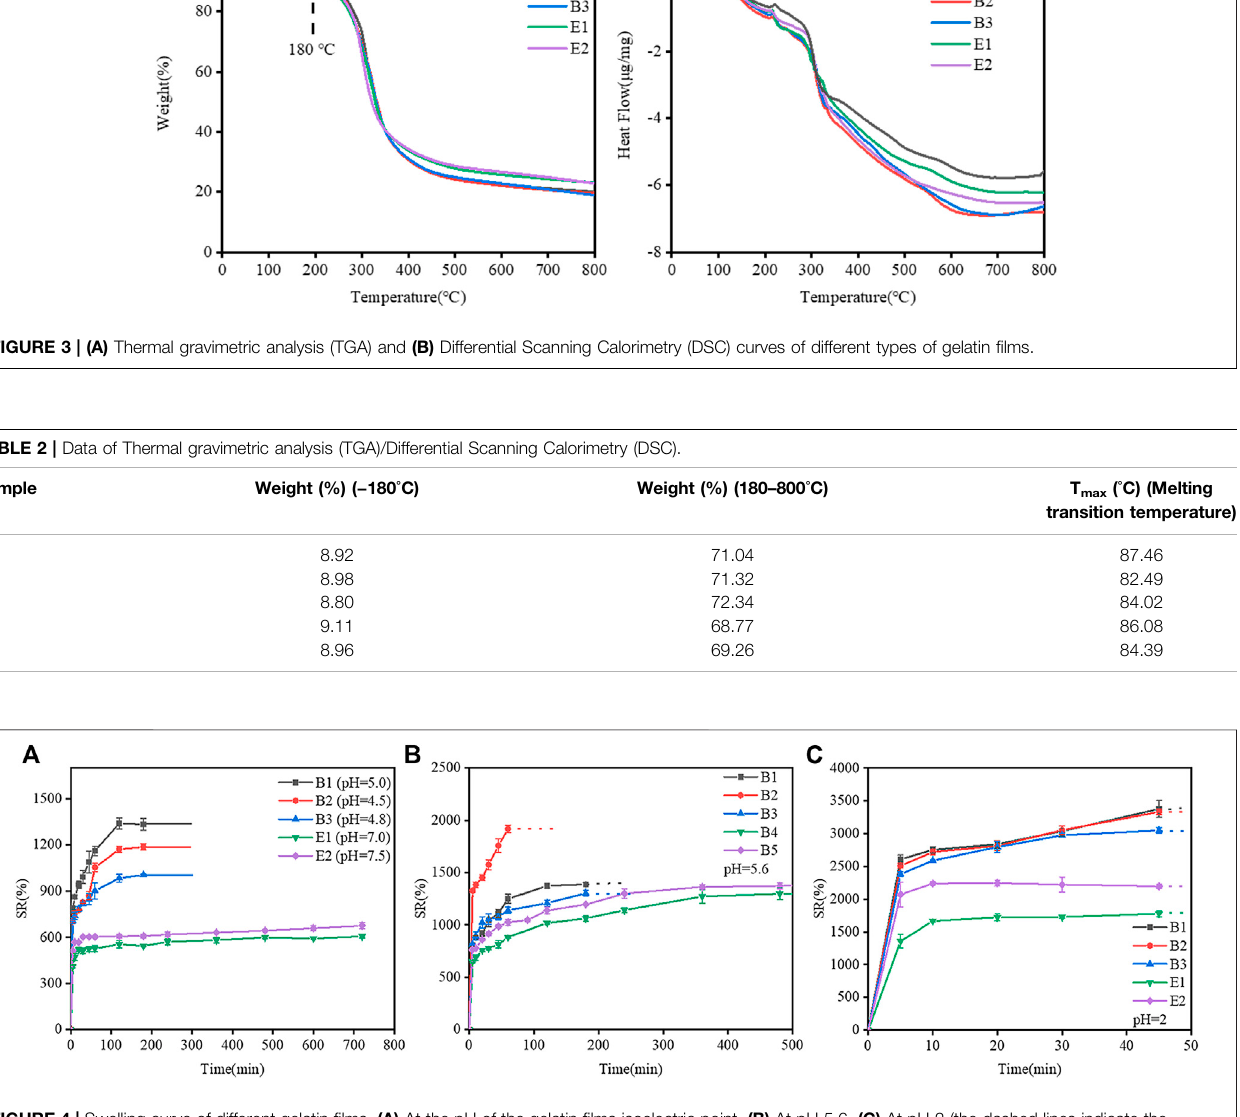
Frontiers in Chemistry |